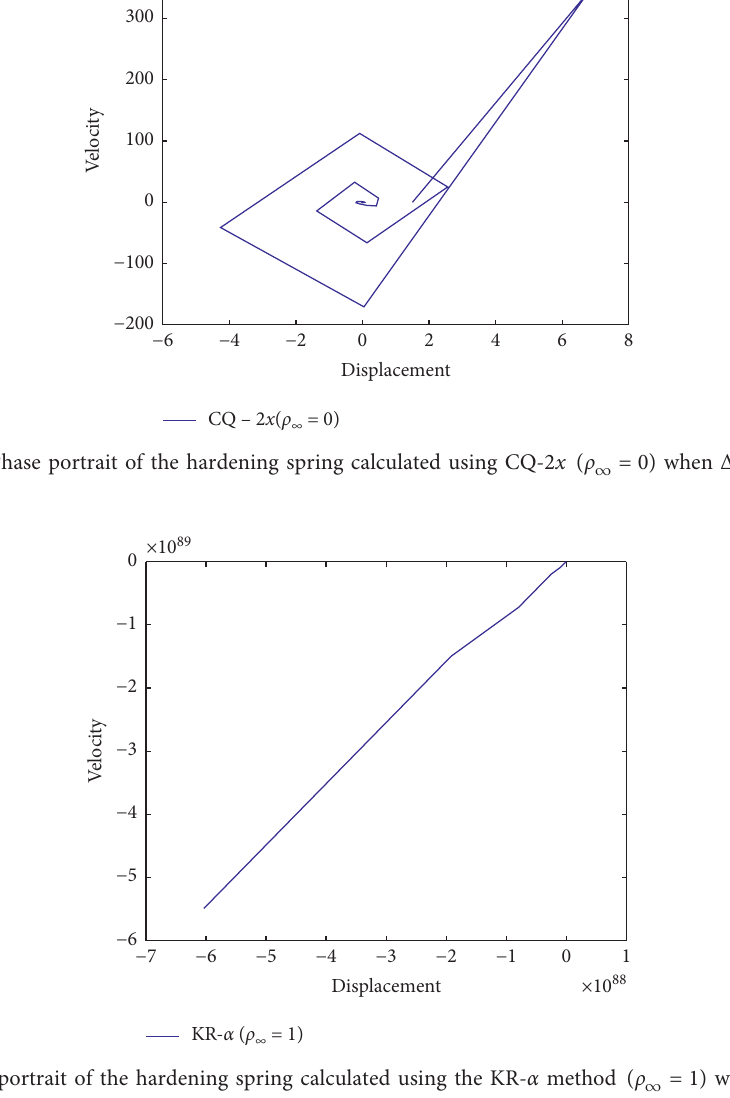
� 1 ) when Δ t � ( 1/2 ) T . ∞